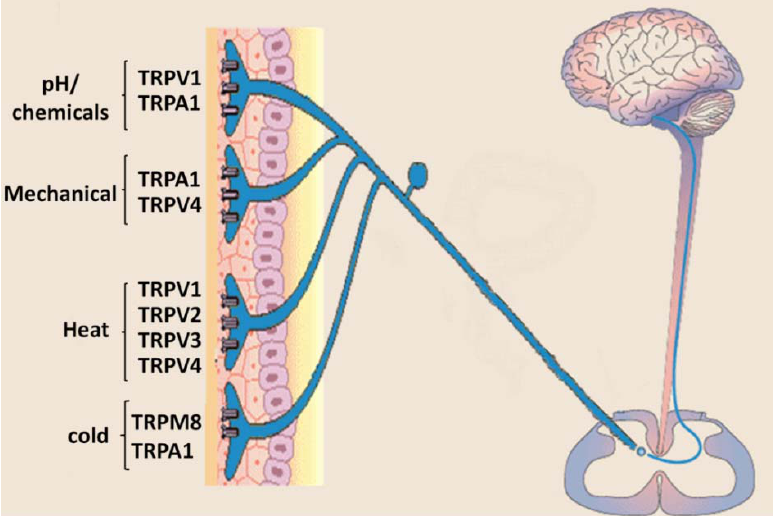
Figure 1. Sensory neurons express multiple transient receptor potential (TRP)